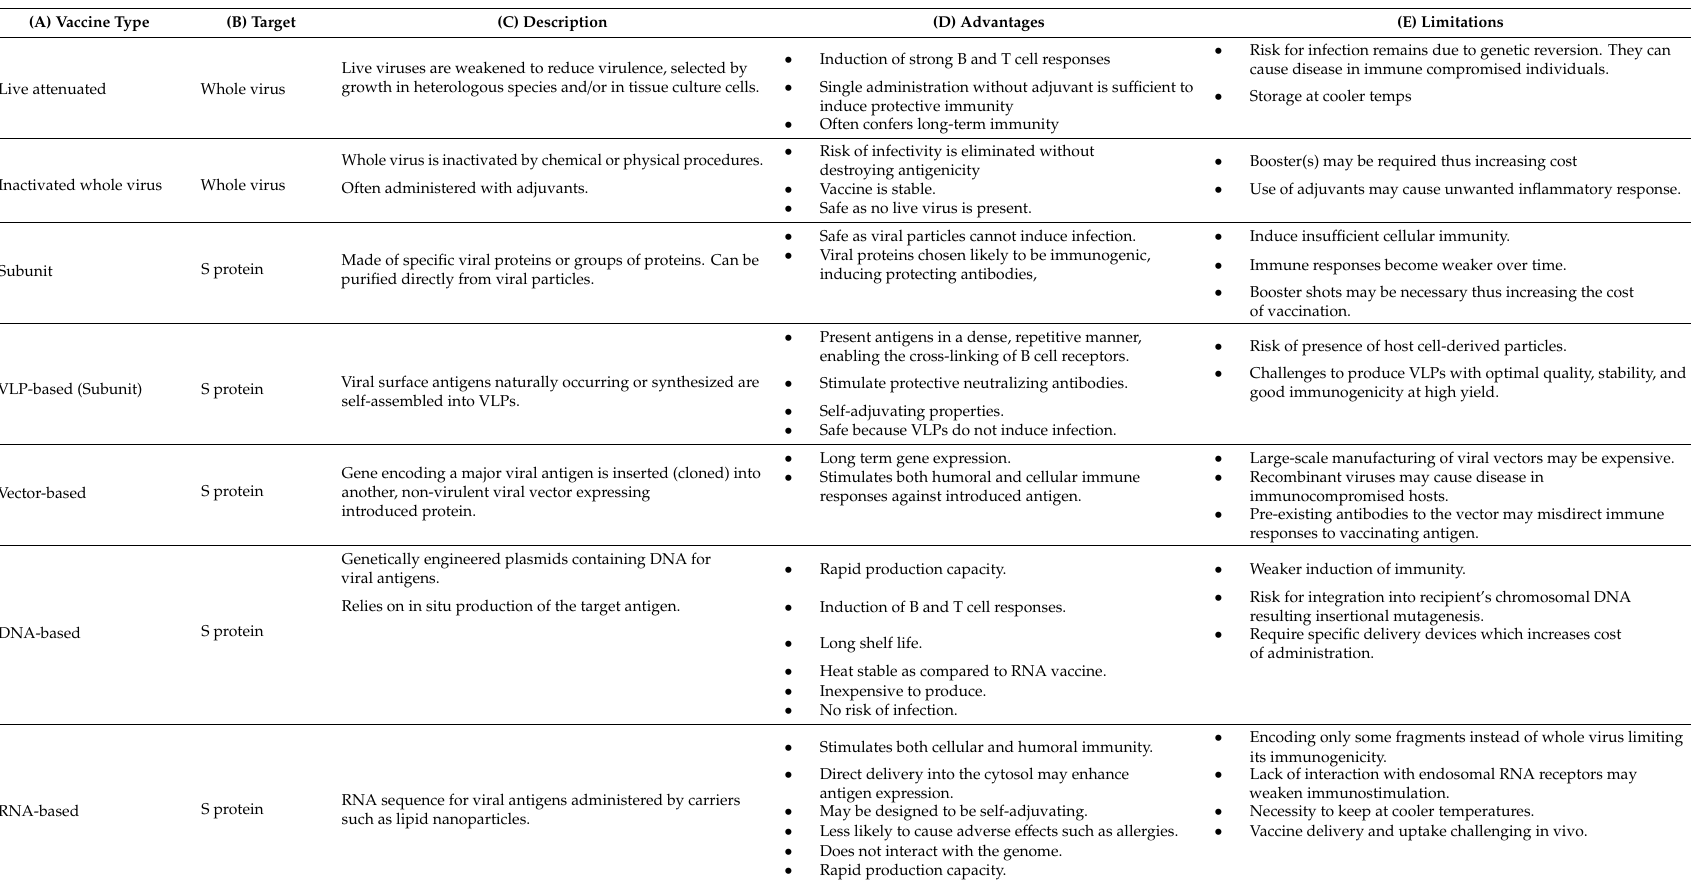
Table 1. Vaccine development platforms against SARS-CoV-2, their viral targets, manufacturing description, advantages, and